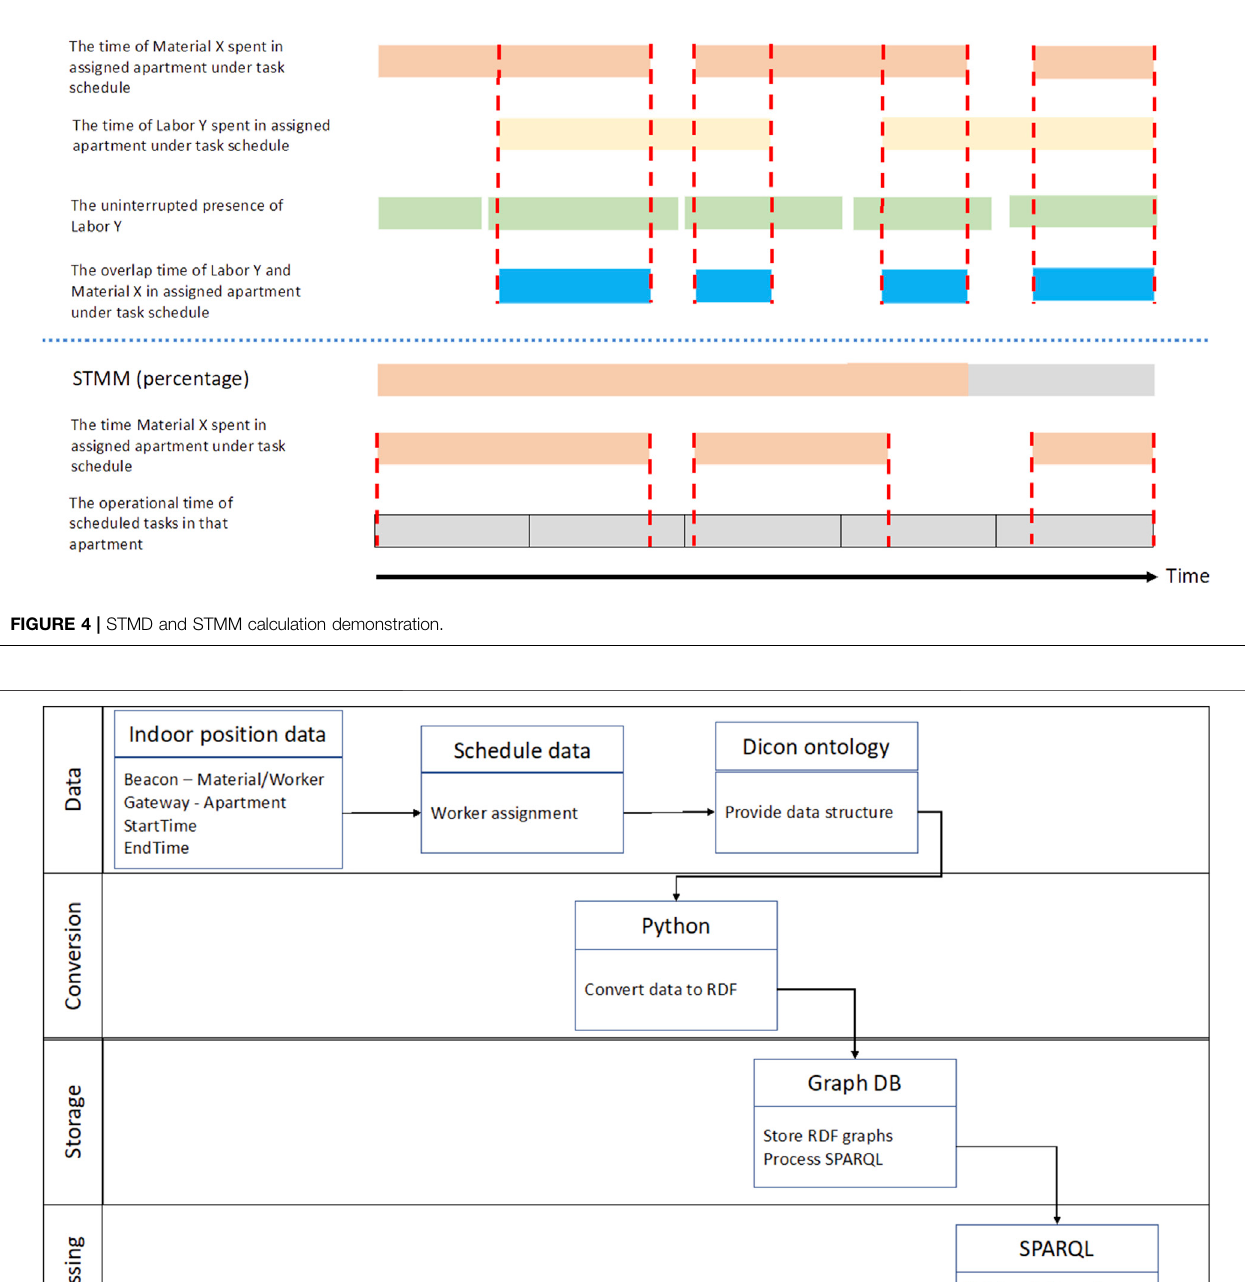
can also be represented based on DiCon. Every record of the indoor positioning system is considered to be an “ event, ” which is observed by a beacon and a gateway during a time interval when